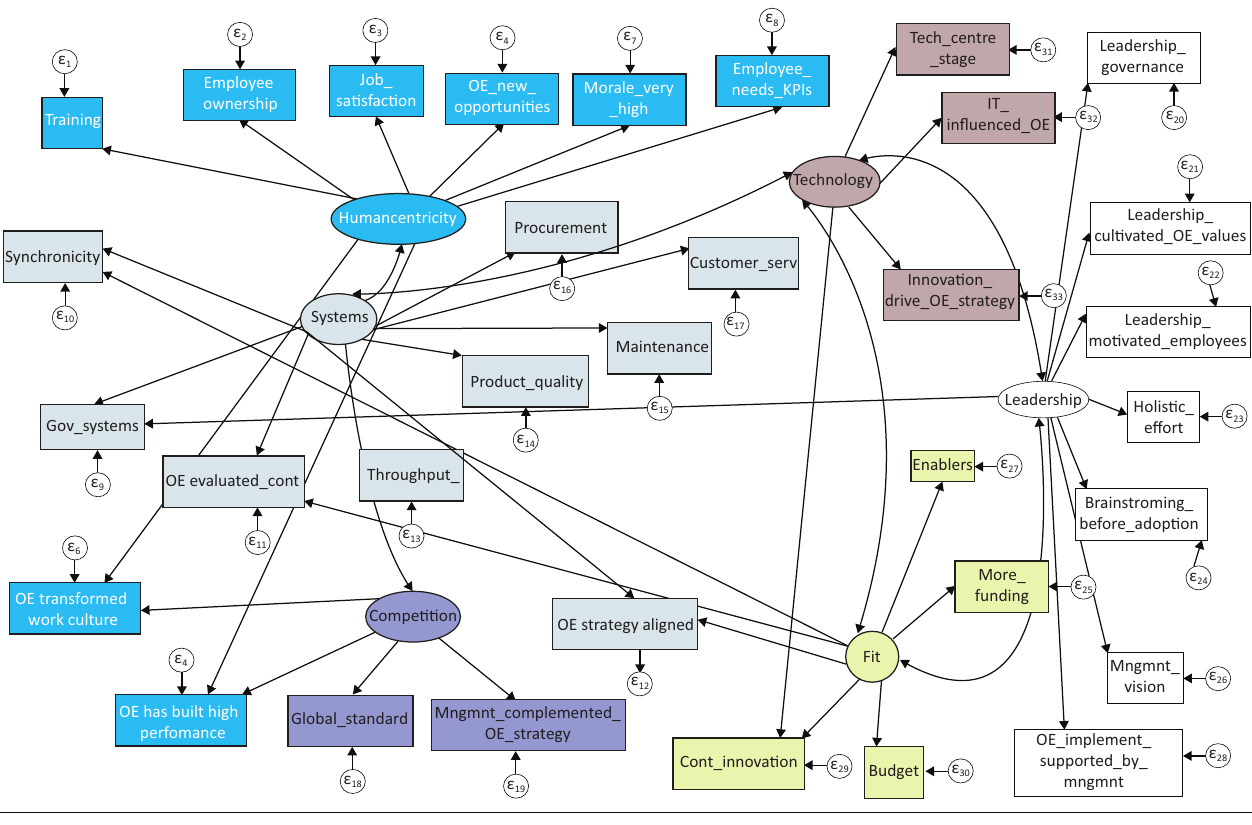
FIGURE 1 : Structural equation